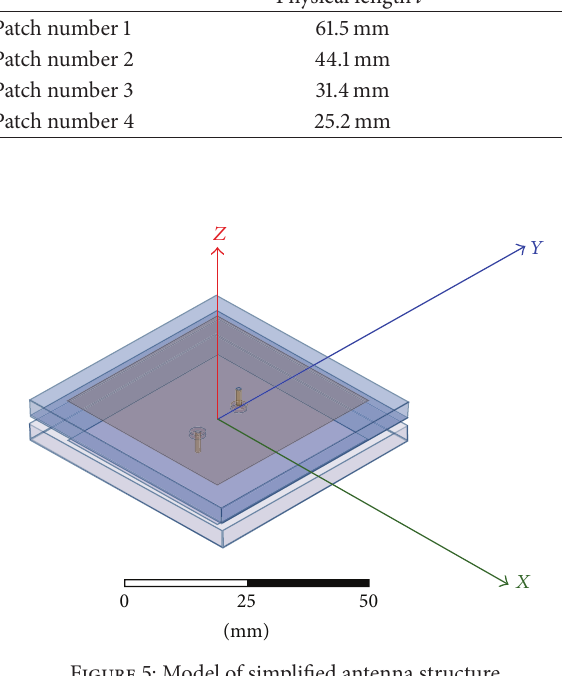
Figure 5: Model of simplified antenna structure.